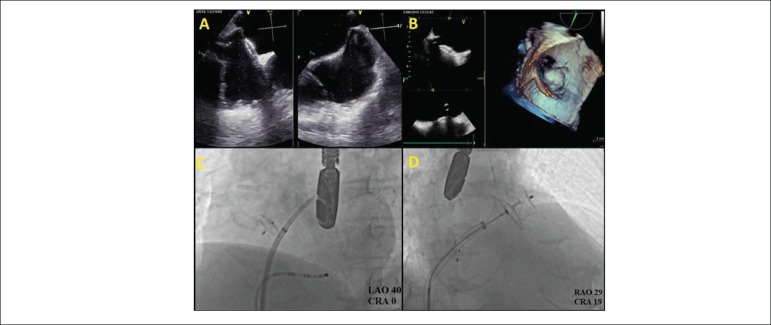
a) Transesophageal echocardiography image of the transseptal puncture needle tenting the inferoposterior site of the interatrial septum and atrial septal defect closure device, b) Tridimensional transesophageal echocardiography guidewire image after the transseptal puncture, c) Fluoroscopic image of the transseptal puncture on the inferoposterior site of the interatrial septum and atrial septal defect closure device, d) Fluoroscopic image of the device before being released.